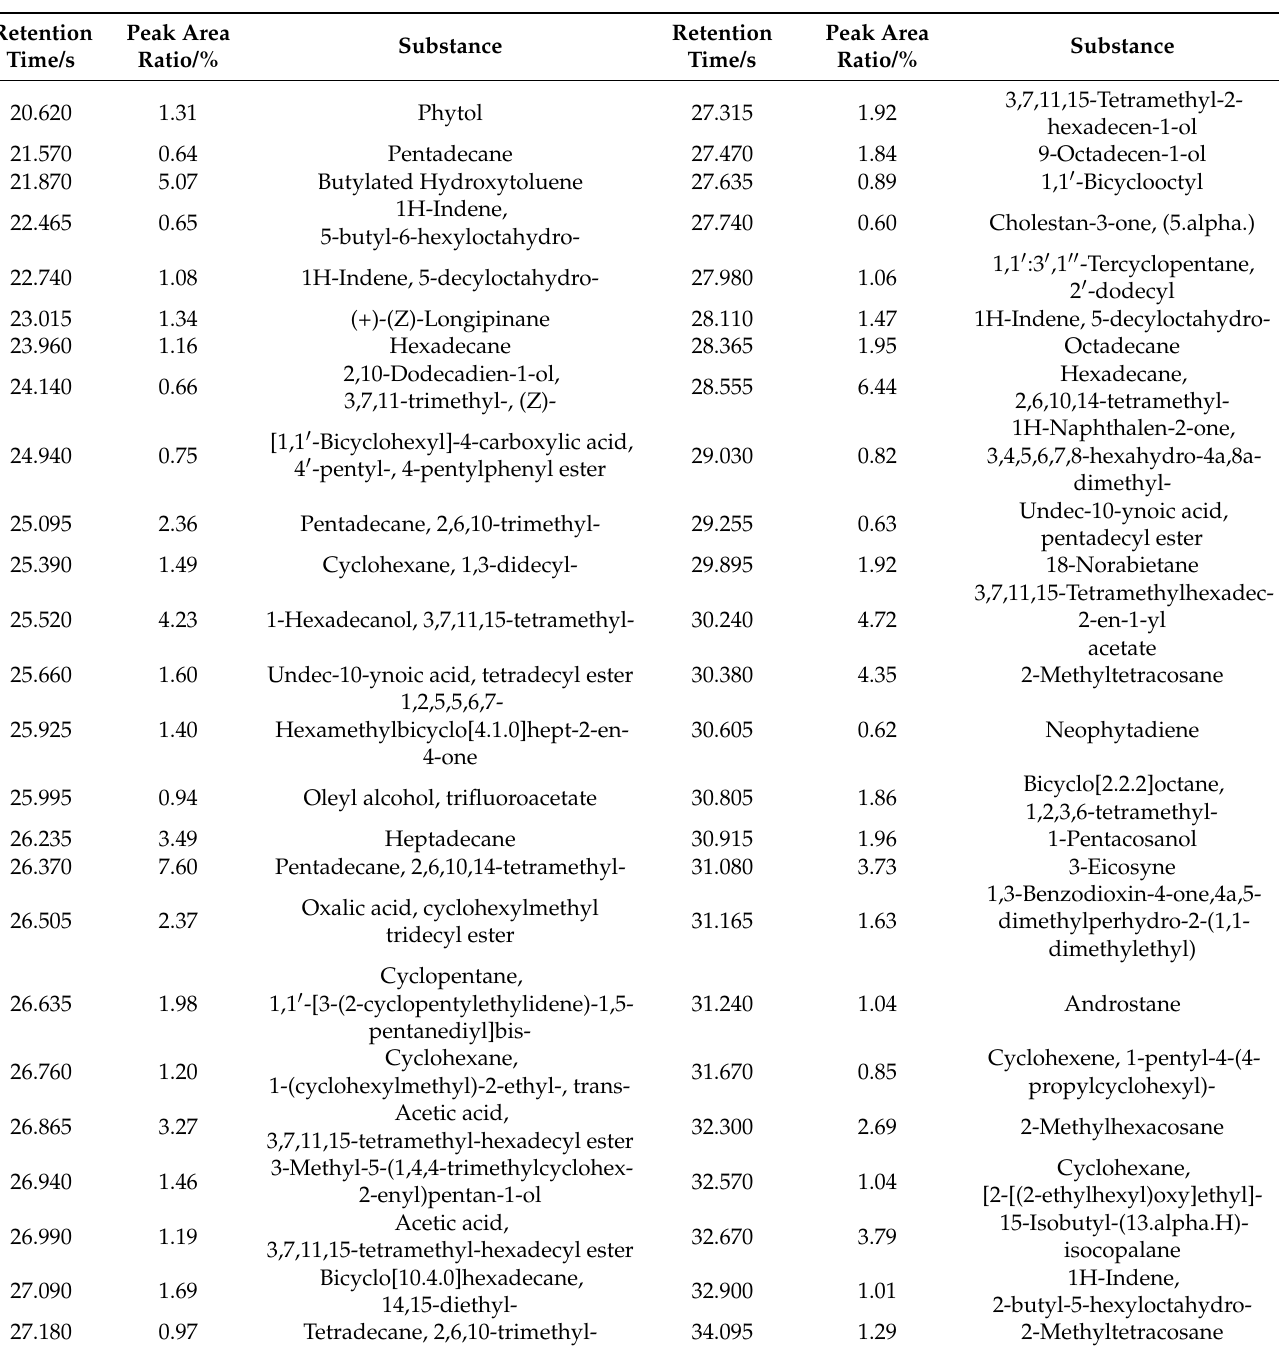
Table 1. The composition of waste oil in the accident oil pool of